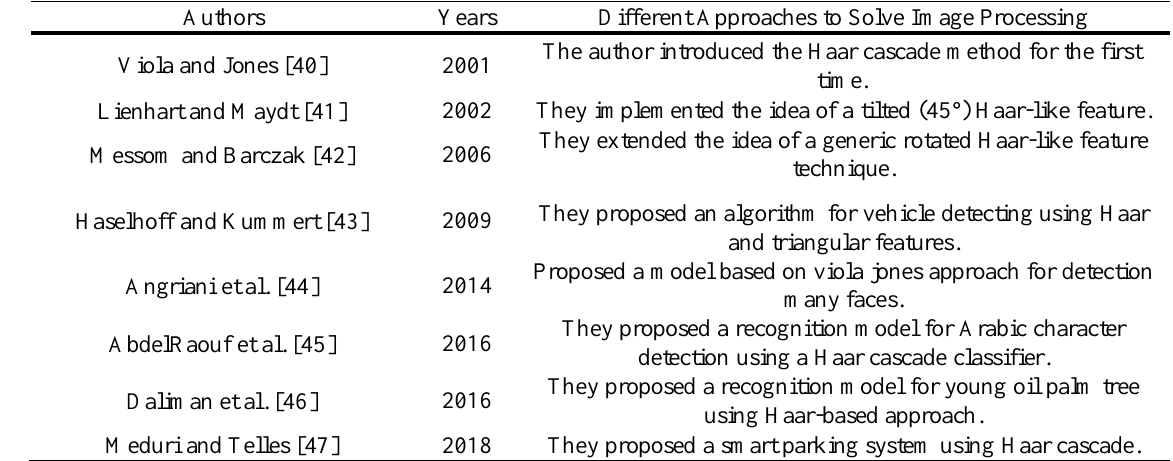
Table 2. A literature review of Haar cascade